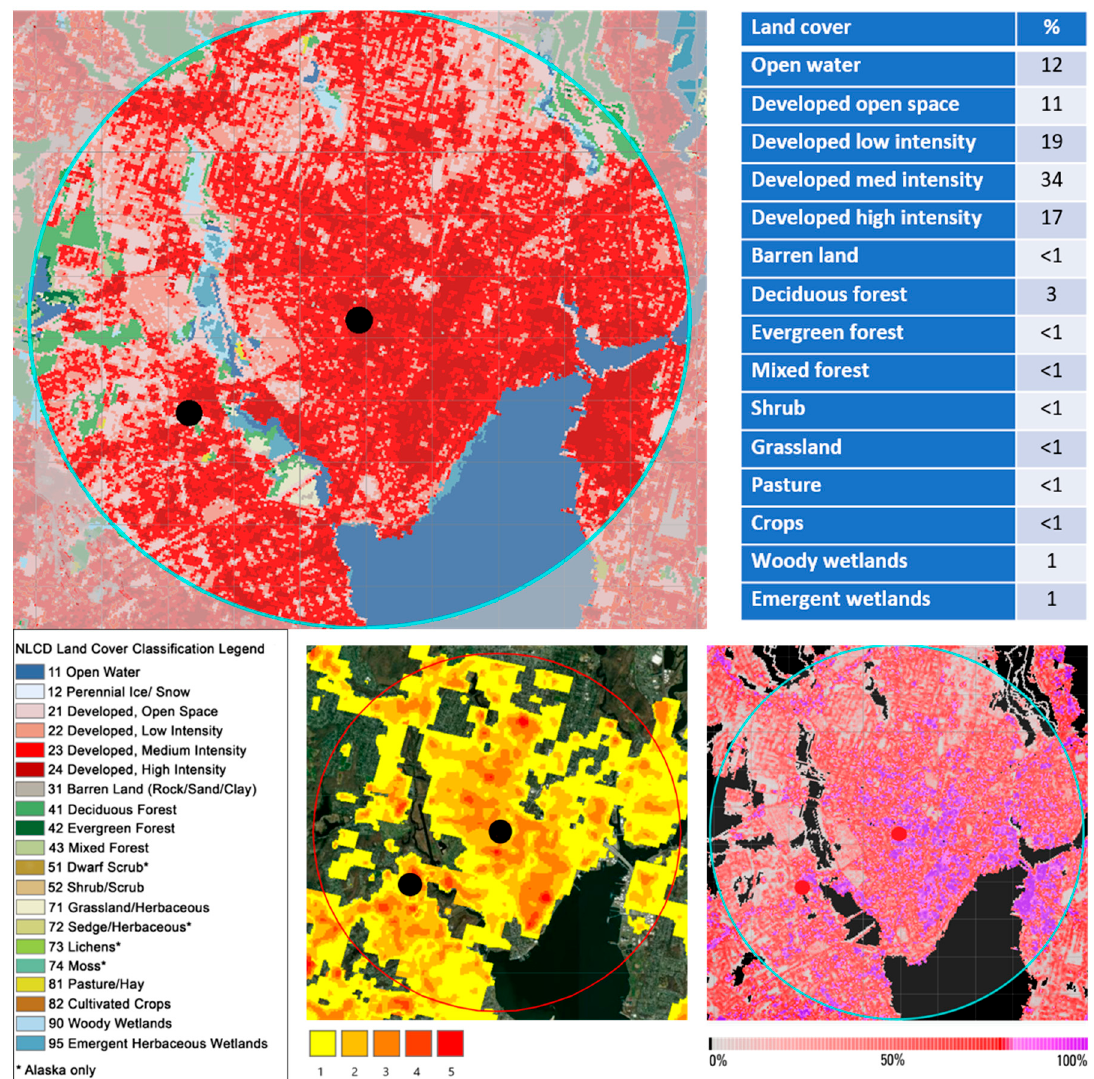
Figure 6. Current land cover characterization of 5 km buffered area around trap sites for current survey (left marker) and 1940s survey (right marker). Clockwise: Land cover 2016 (NLCD); urban impervious surfaces 2016 (NLCD); urban heat island severity 2019–2020 (The Trust for Public Land). The urban heat island scale 1 to 5 scale is described as 1: heat area slightly above the mean for the city and 5: heat area significantly above the mean for the city.